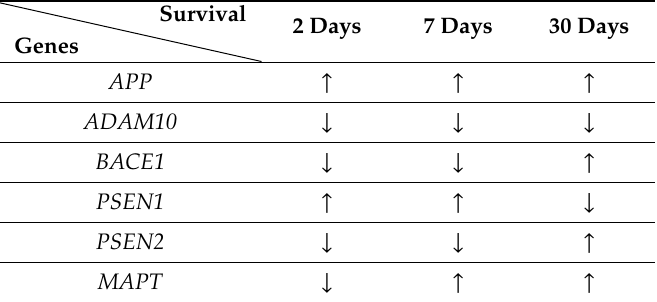
Table 2. Changes in the expression of Alzheimer’s disease-associated genes in the CA3 area of hippocampus at di ff erent times after experimental brain ischemia [63]. Survival 2 Genes